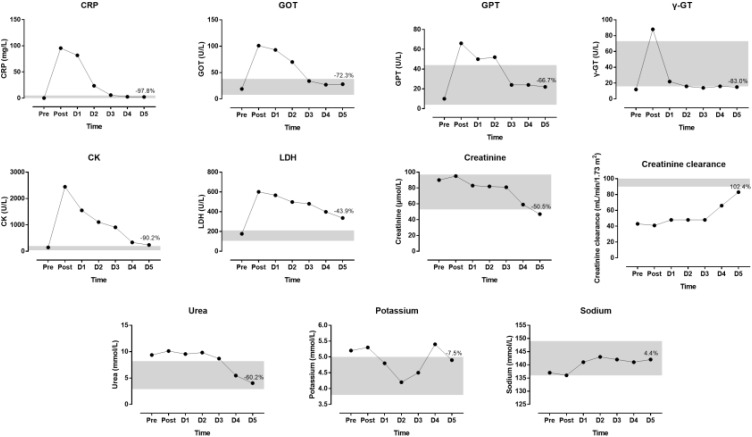
Biochemical indices during the race and recovery. The shadowed area represents normal reference values. The percentage value over D5 point denotes change from post-race value. D, day post-race.